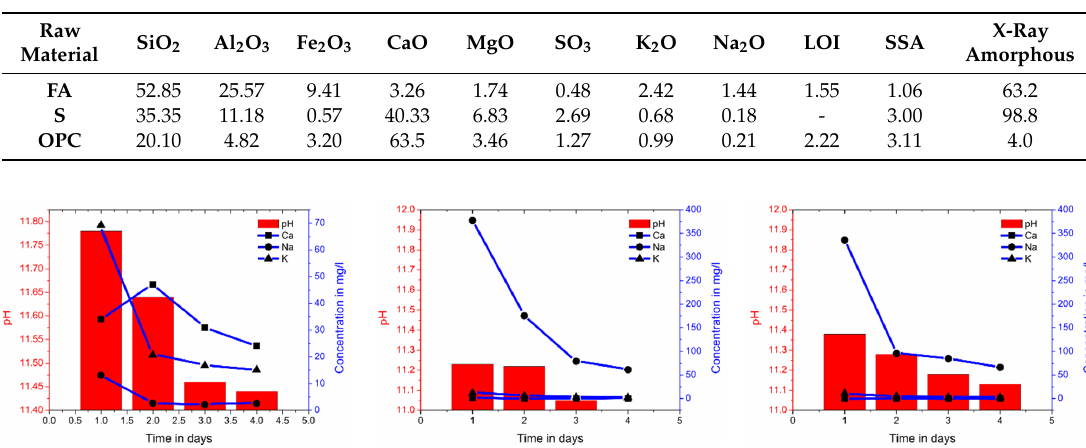
Table 1. Chemical composition based on X-ray fluorescence spectroscopy (XRF) analyses in wt%, loss on ignition (LOI) in wt%, specific surface area (SSA) in m²/g and X-ray amorphous portion on the basis of the X-ray diffraction (XRD) Rietveld analyses in wt% Abbreviations: FA, fly ash; OPC, ordinary Portland cement; S, blast furnace slag.